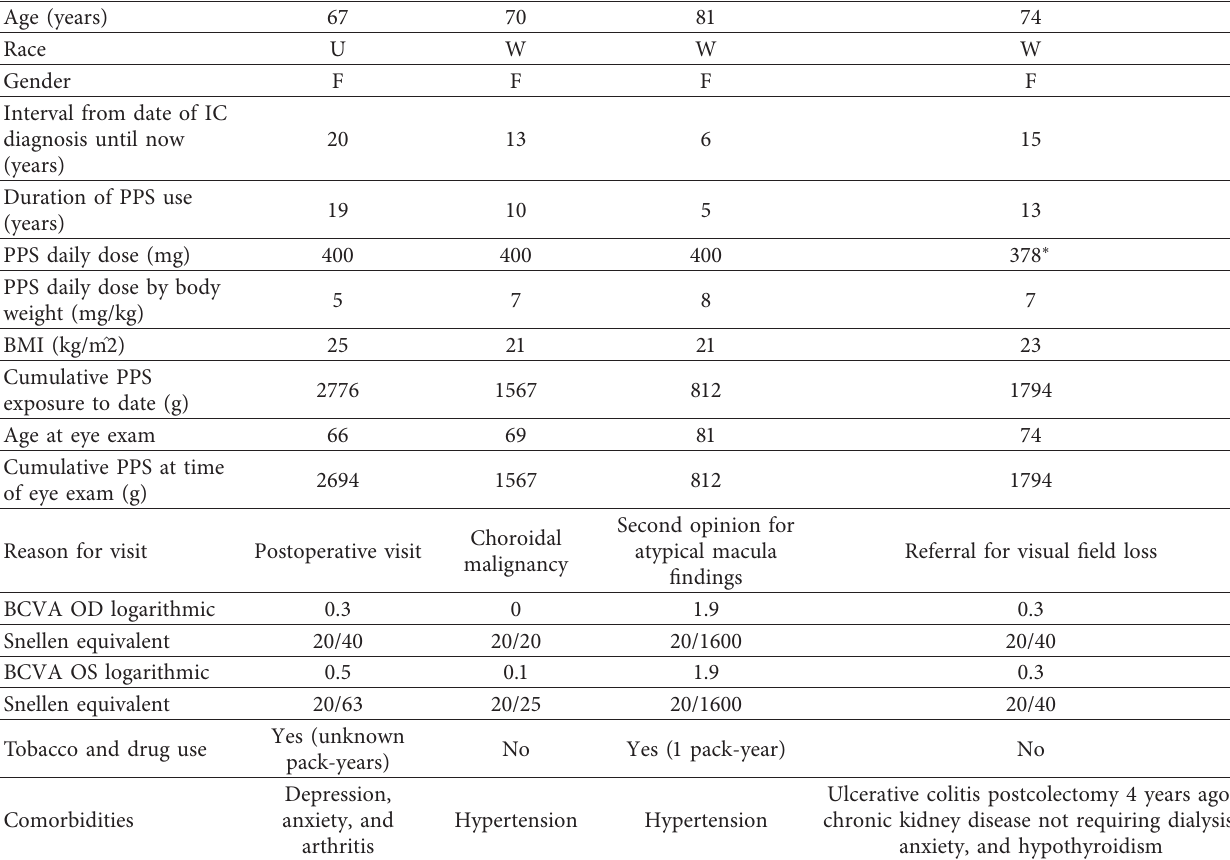
Table 2: Detailed clinical information of the 4 identified cases of pentosan polysulfate sodium associated maculopathy. U � unknown and W � white ∗